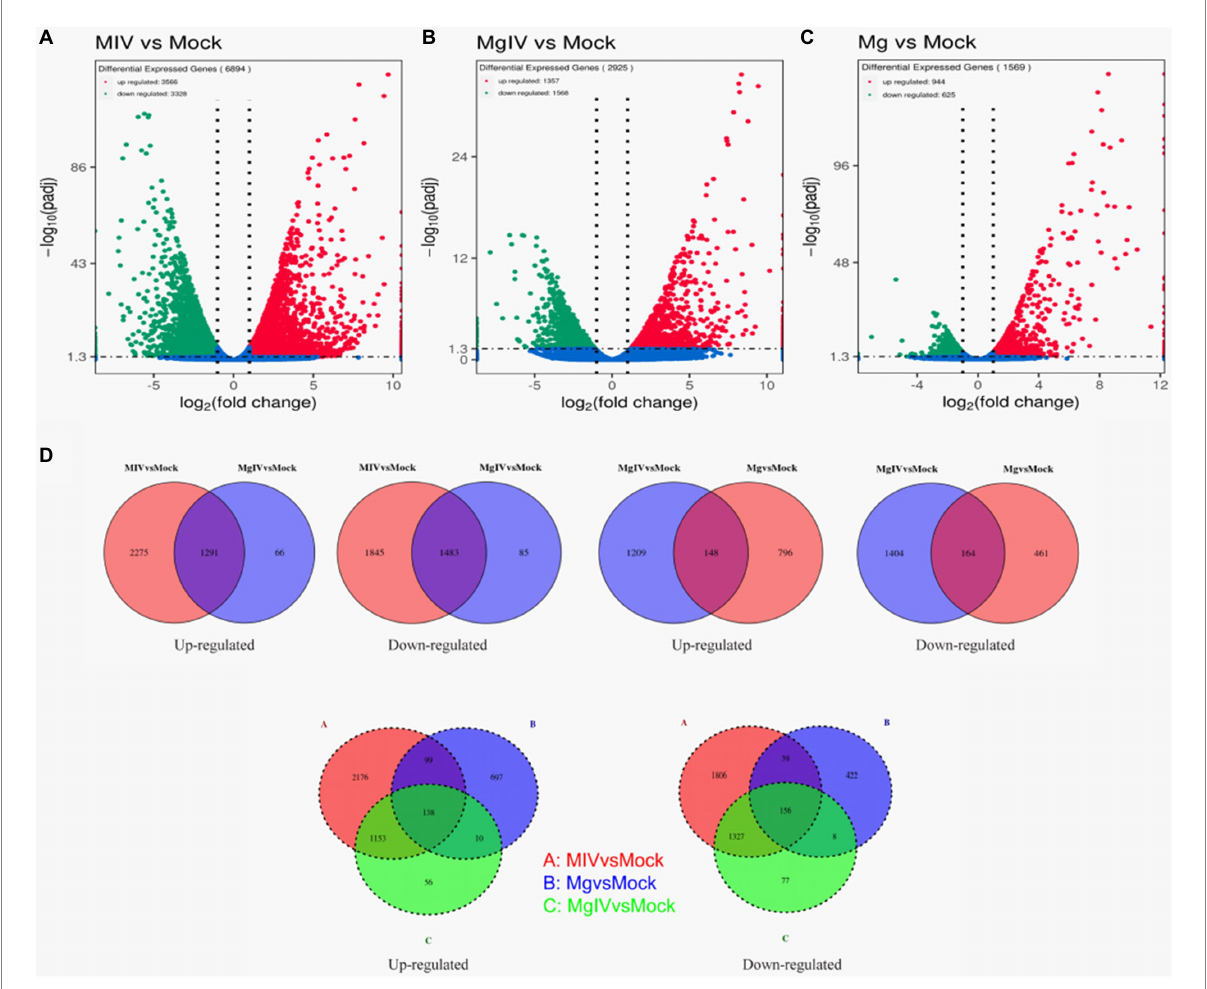
FIGURE 2 Volcano plot and Venn image of global DEGs in different comparison groups. Volcano plot of global DEGs in different comparison groups. (A) MIV vs. Mock. (B) MgIV vs. Mock. (C) Mg vs. Mock. (D) Venn diagrams representing the genes in common among treatment groups. (The statistical criteria are padj < 0.05, |Log2FC| >